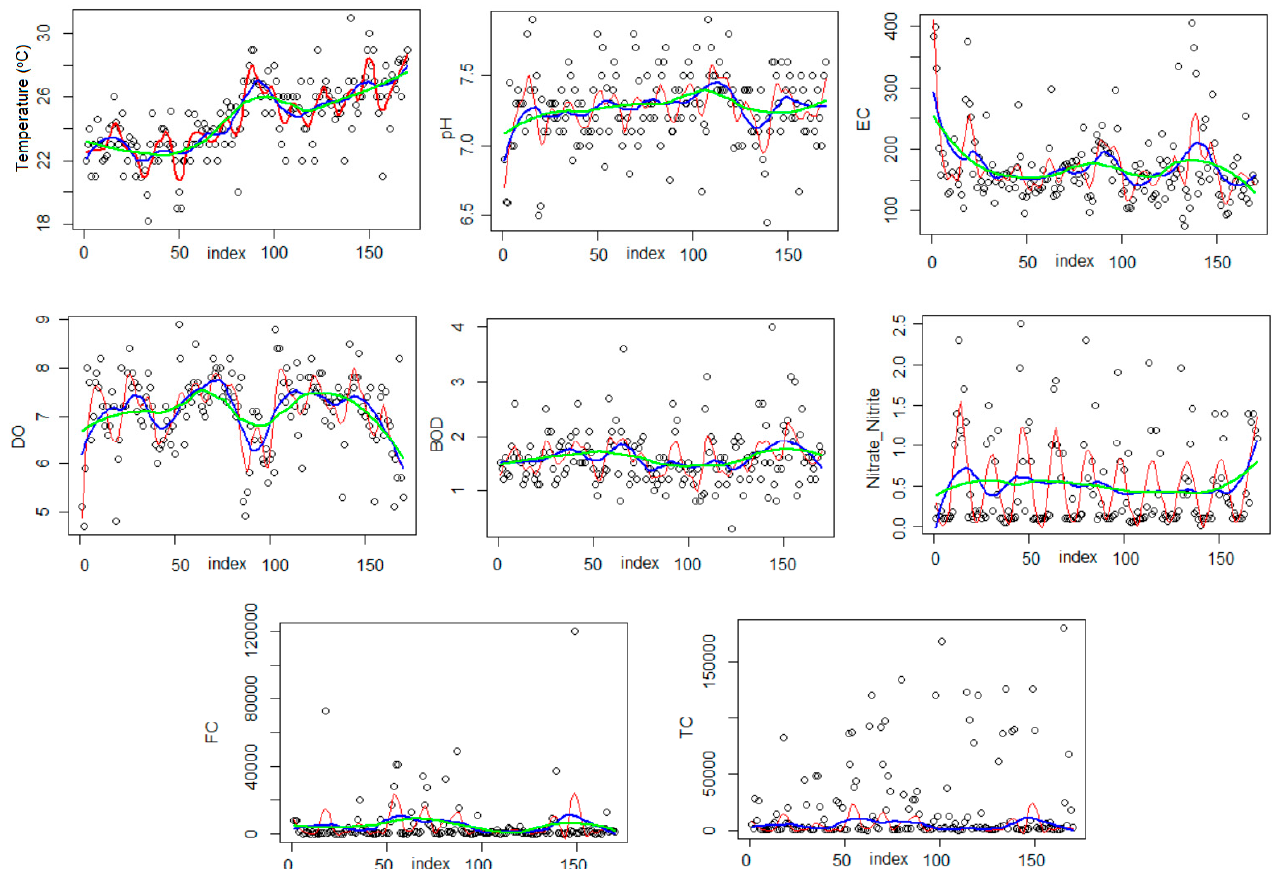
Figure 3. Loess trend for spatio ‐ temporal variation in the water parameters. The red curve corresponds to α = 0.10, the blue one, to α = 0.25, and the green one, to α = 0.50.